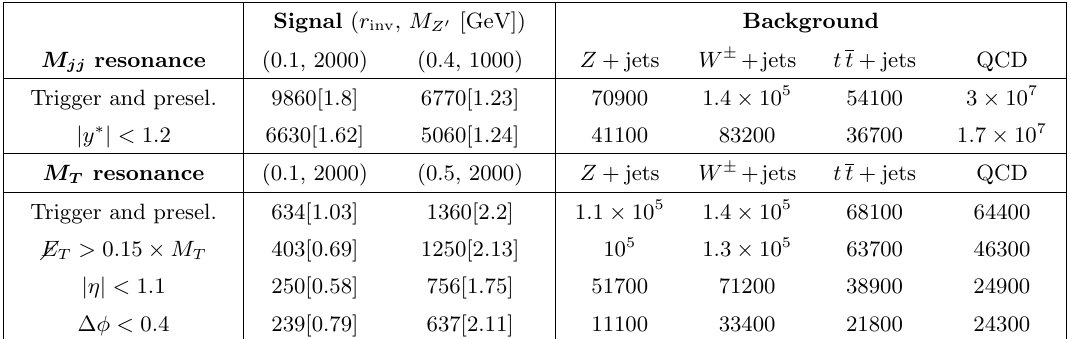
Table 2 . Cut-(cid:13)ow table for s -channel production for g q = 0 : 1 and g (cid:31) = 1 are assumed for the signal. The numbers in brackets correspond to an estimate of the signi(cid:12)cance s= p s + b at each stage of the cut-(cid:13)ow, where s ( b ) is the number of signal(background)